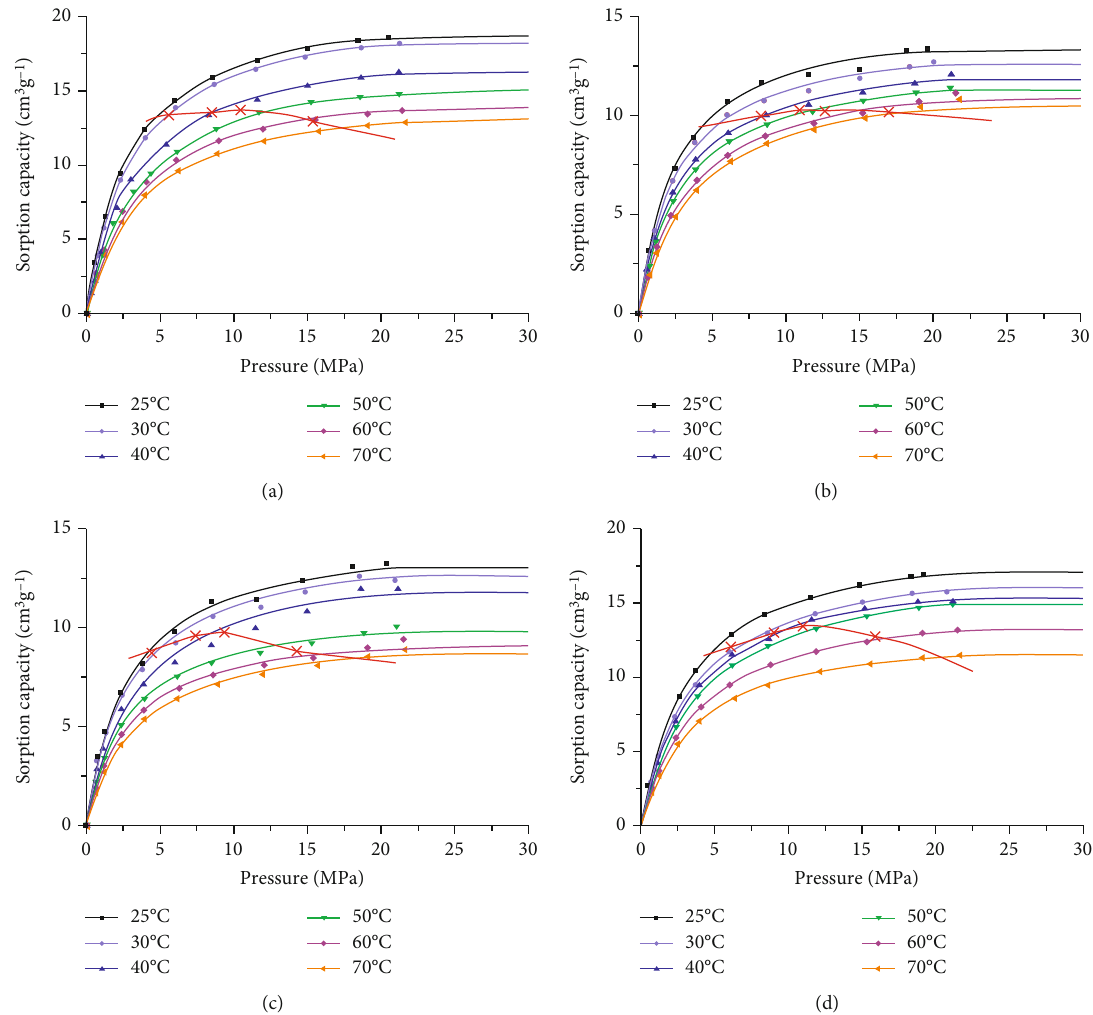
Figure 7: The methane adsorption capacity at di ff erent temperatures and pressures. Four samples DQ (a), ML (b), TL (c), and XQ (d) are from the domains of B1 (sample b) and B3 (samples a – d), respectively. The sorption capacities curve (red line) was plotted at the pressure and temperature conditions from reservoir subsidence and geothermal fi eld history (the pressure gradient was set as 1.0MPa/100